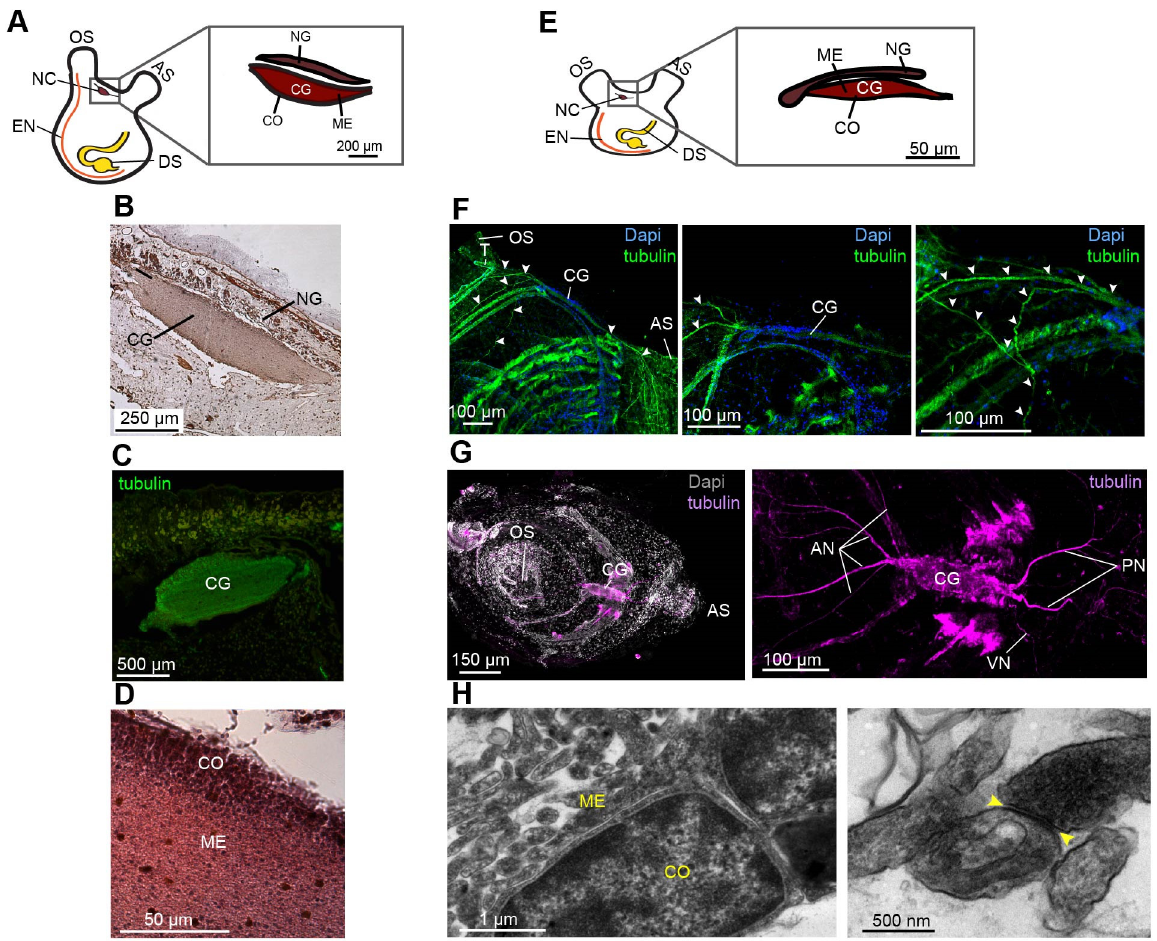
Figure 1. Comparative CNS morphology reveals minimal plasticity at different life stages. ( A – D ) P. mytiligera CNS morphology during the adult life stage. ( A ) Illustration depicting adult body plan, highlighting the CNS, located between the two siphons, and its components, the cerebral ganglion (CG), medulla (ME), cortex (CO) and neural gland (NG). ( B , C ) Representative histological and immunohistochemistry staining of the cerebral ganglion. ( D ) Representative histological section of the cerebral ganglion. ( E – H ) P. mytiligera CNS morphology during the juvenile life stage. ( E ) Illustration depicting juvenile body plan highlighting the CNS, located between the two siphons and its components: the cerebral ganglion and the neural gland. ( F ) Whole mount immunofluorescence of P. mytiligera cerebral ganglion. Maximum intensity projections of confocal stacks. White arrows indicate nerve fibers. ( G ) Whole mount fluorescent in situ hybridization of tubulin showing the cerebral ganglion and associate nerves; anterior nerves (AN), posterior nerve (PN), and visceral nerve (VN). ( H ) Transmission electron microscopy images of P. mytiligera neural complex showing the brain structures; medulla (ME) and cortex (CO). Synapse in the medulla is marked with yellow arrows. Atrial siphon (AS), digestive system (DS) endostyle (EN) and oral siphon (OS).